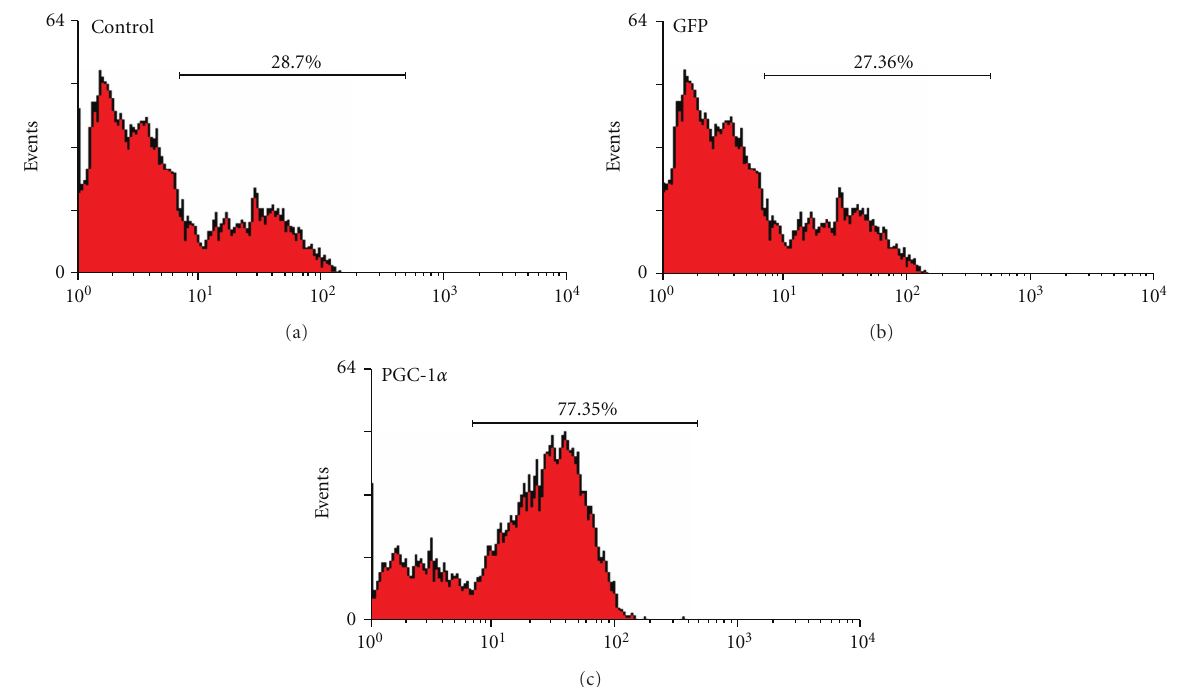
Figure 4: Phagocytosis of VSMCs. VSMCs deprived of serum for 24h were infected by Ad-PGC-1 α or Ad-GFP. After 48 h, VSMCs were incubated with 1 μ m microspheres (2.7 × 10 6 beads per mL) for 10h. 27.36% of VSMCs infected by Ad-GFP had phagocytotic activity. However, the proportion of VSMCs having phagocytotic activity increased to 77.45% after overexpression of PGC-1 α